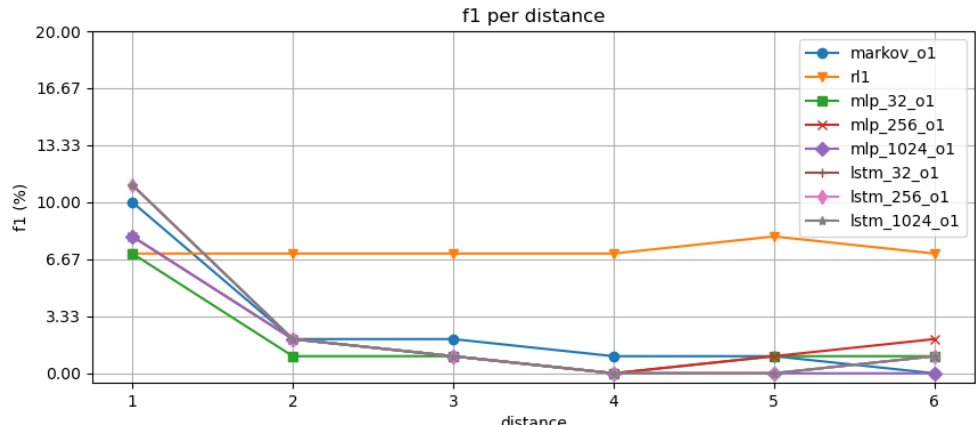
Figure 6. F1 comparison between the baseline and the RL-based models.